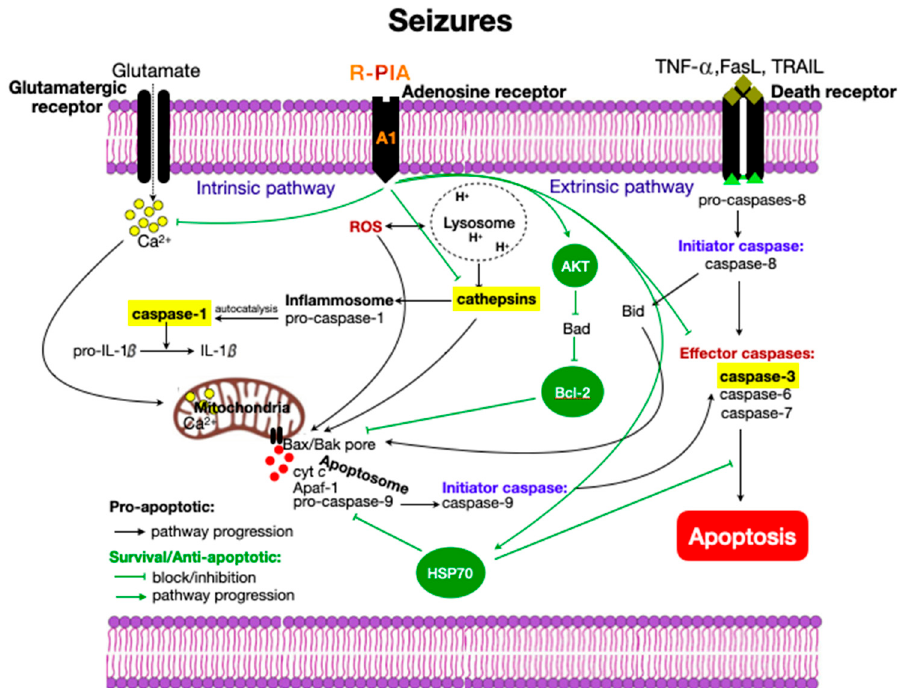
Figure 6. Molecular signaling activated by seizures leading to cell death by apoptosis. Two pathways, extrinsic and intrinsic, may trigger apoptosis. TNF (tumor necrosis factor) activates cell-surface death receptors in the extrinsic pathway, leading to an intracellular death-inducing signaling complex containing Fas-associated death domain and caspase-8 or -10. A caspase cascade is initiated by the activation of “effector” caspases, such as caspase-3, which cleave essential intracellular structural and survival proteins and lead to apoptosis. The intrinsic pathway is triggered by increased intracellular calcium, free radicals, and dimerization interactions of Bcl-2 family proteins that regulate mitochondrial dysfunction. Mitochondrial alteration leads to cytochrome c release, which activates the apoptosome formed by Apaf-1 (apoptotic protease-activating factor 1) and caspase-9, followed by downstream executioner caspases. Reactive oxygen species (ROS) and in- tracellular calcium can alternatively induce lysosomal disruption, releasing cathepsins. Cathepsins may directly trigger cytochrome c release, leading to caspases activation. Caspase-1 is activated by the inflammasome and converts pro-IL-1B to mature IL-1B. These pathways can be modulated by survival proteins AKT, anti-apoptotic Bcl-2, and HSP-70. The A1Rs (adenosine A1 receptors) are effective modulators of excitatory transmission where they exert combined pre-, post-, and non- synaptic effects to decrease glutamate excitability. In this manner, the activation of presynaptic A1R by R-PIA reduces the influx of calcium through voltage-sensitive calcium channels and con- sequently inhibits the release of glutamate; at the post-synaptic level, it inhibits voltage-sensitive calcium channels and the NMDA receptor function; and finally, at the neuronal non-synaptic level, it hyperpolarizes neurons by modulating potassium channel conductance. Finally, R-PIA, by activating A1R, reduces cathepsin D release and increases the levels of survival proteins AKT and HSP70 as well as the anti-apoptotic response.